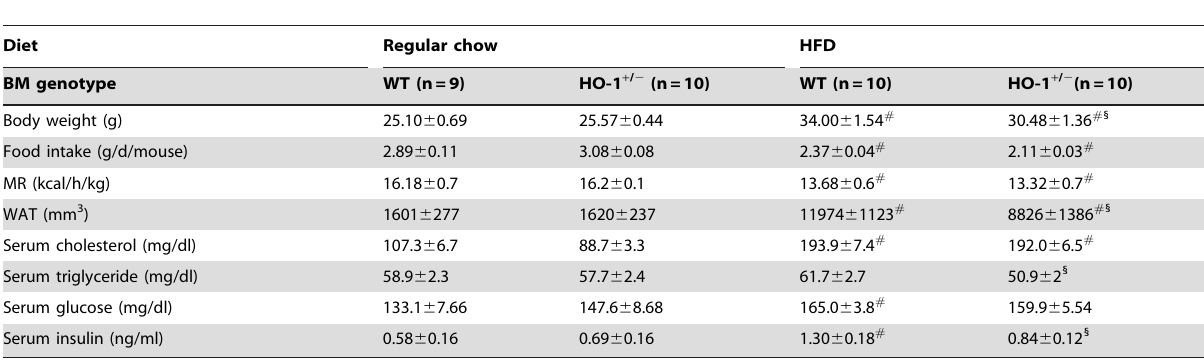
Table 1. Metabolic parameters of the WT and HO-1 + / 2 chimeras fed regular chow diet or HFD.